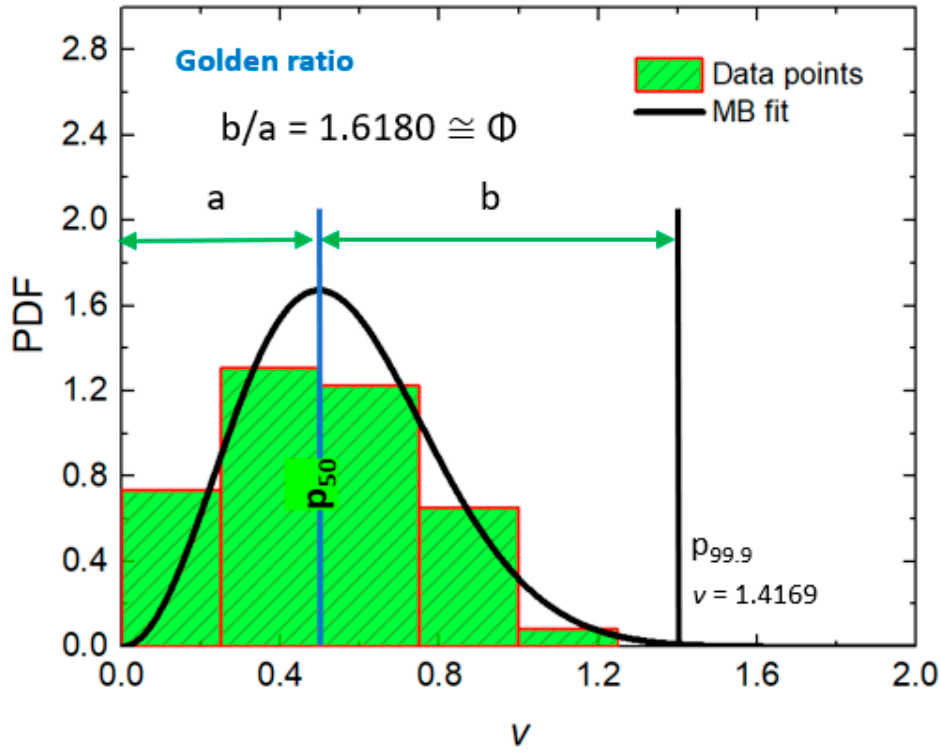
Figure 3. MB-like distribution ( χ for k = 3 and 𝐵 = 0.123 ) obtained from response time data with a